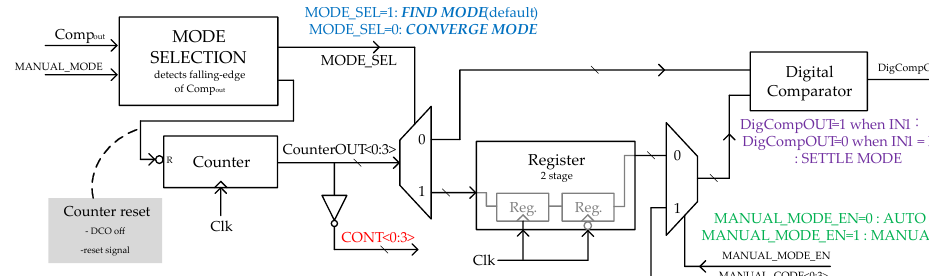
Figure 8. Bias calibration block